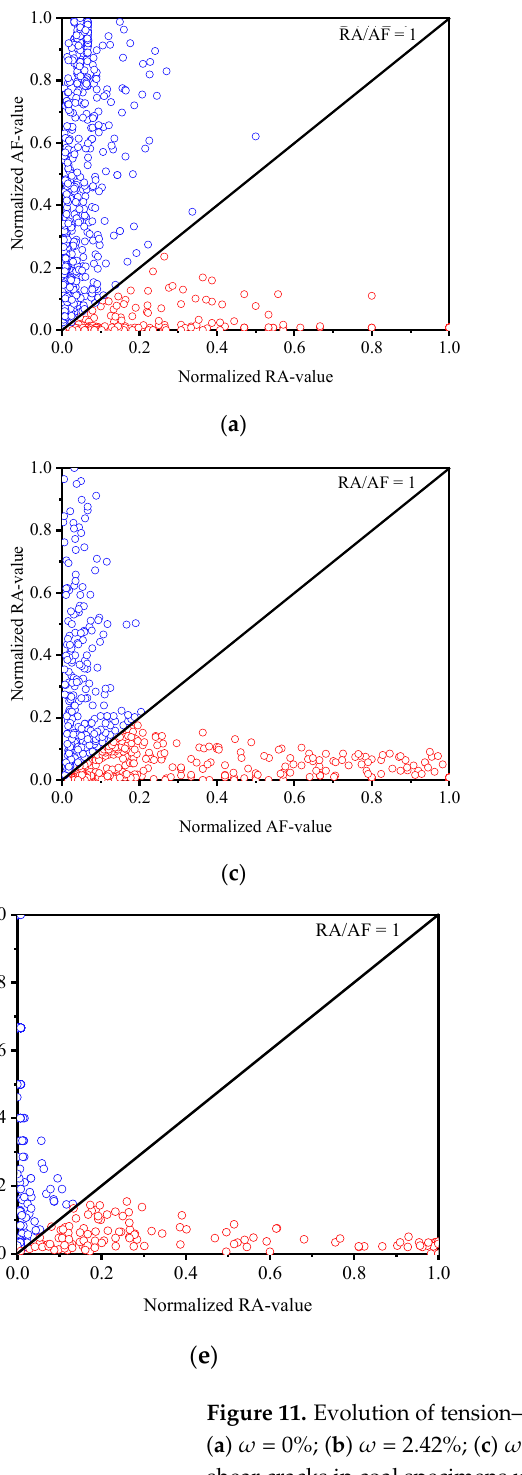
0°). ( a ) ω = 0%; ( b ) ω = 2.42%; ( c ) ω = 5.53%; ( d ) ω = 7.55%; ( e ) ω = 10.08%; ( f ) The ratio of tensile and shear cracks in coal specimens under different moisture contents.